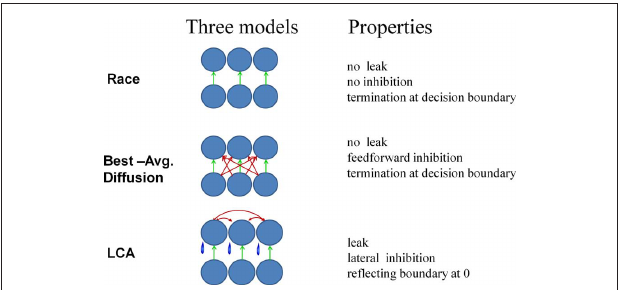
Figure 2 | Neural implementation of perceptual choice models for the interrogation paradigm (top row): Pure race model; (middle row) Niwa and Ditterich (2008) diffusion model; (bottom row) LCA model (usher and McClelland, 2001). Green arrows correspond to excitation and red to inhibition. Blue “tears” represent leakage in the LCA model.